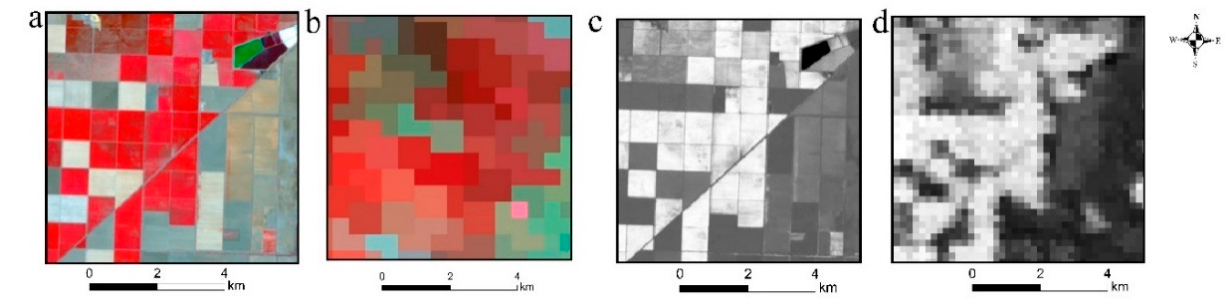
Figure 3. FSDAF input images ( a ) Landsat 30 m image on DOY 206; ( b ) MOD09GA 500 m image on DOY 206; ( c ) Landsat 30 m NDVI on DOY 206; ( d ) MODIS 250 m NDVI on DOY 193).